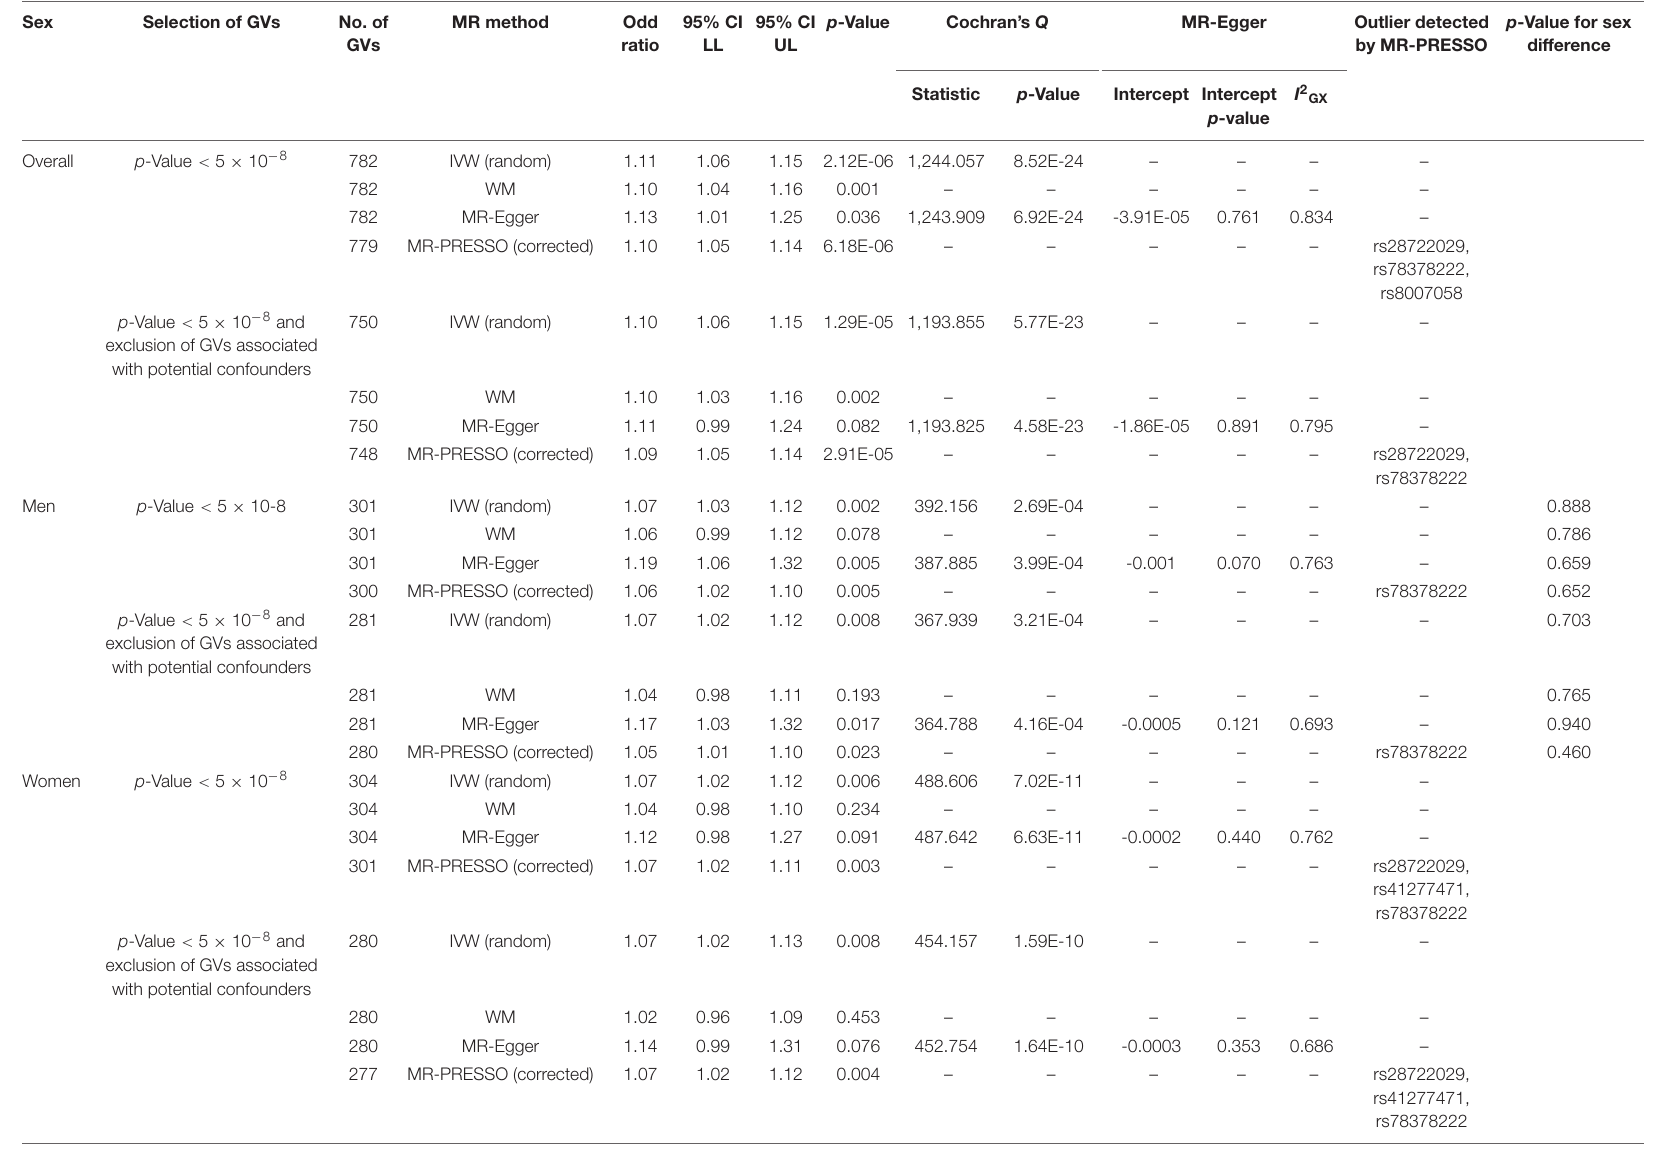
TABLE 3 | Univariable Mendelian randomization association of basal metabolic rate with neoplasm. Sex Selection of GVs